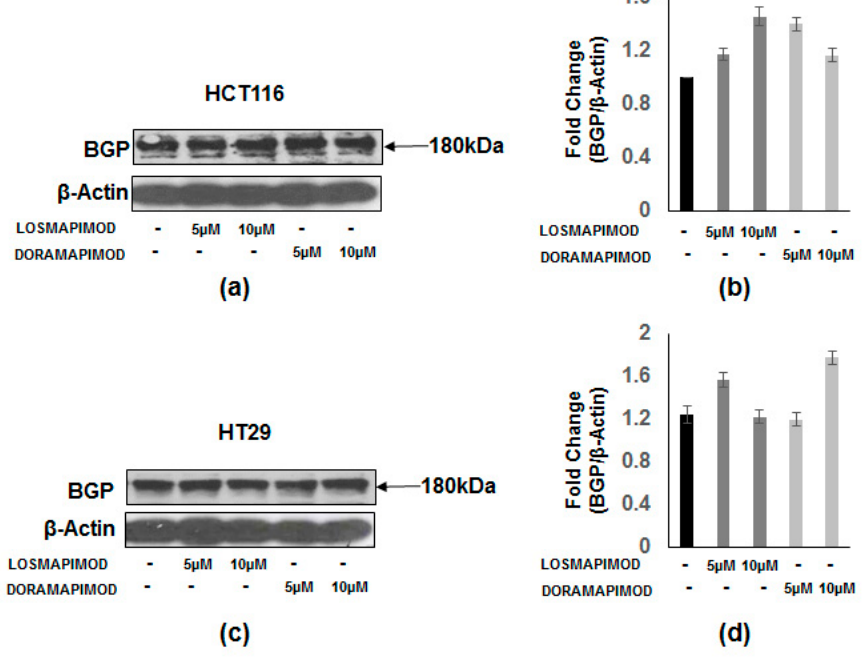
Figure 7. Lack of inhibition of biliary glycoprotein (BGP) protein levels by losmapimod or doramapimod by in colon cancer cells. ( a , b ) HCT-116 and ( c , d ) HT-29 CRC cells were treated with di ff erent doses of losmapimod or doramapimod or DMSO (control) for 48 h. Whole cell extracts were prepared and SDS-PAGE was performed followed by Western blotting with specific BGP antibodies. Equal loading was confirmed with β -actin. Panels ( b , d ) depict the resultant densitometric values showing fold change of the ratio of BGP / β -actin in HCT-116 and HT-29